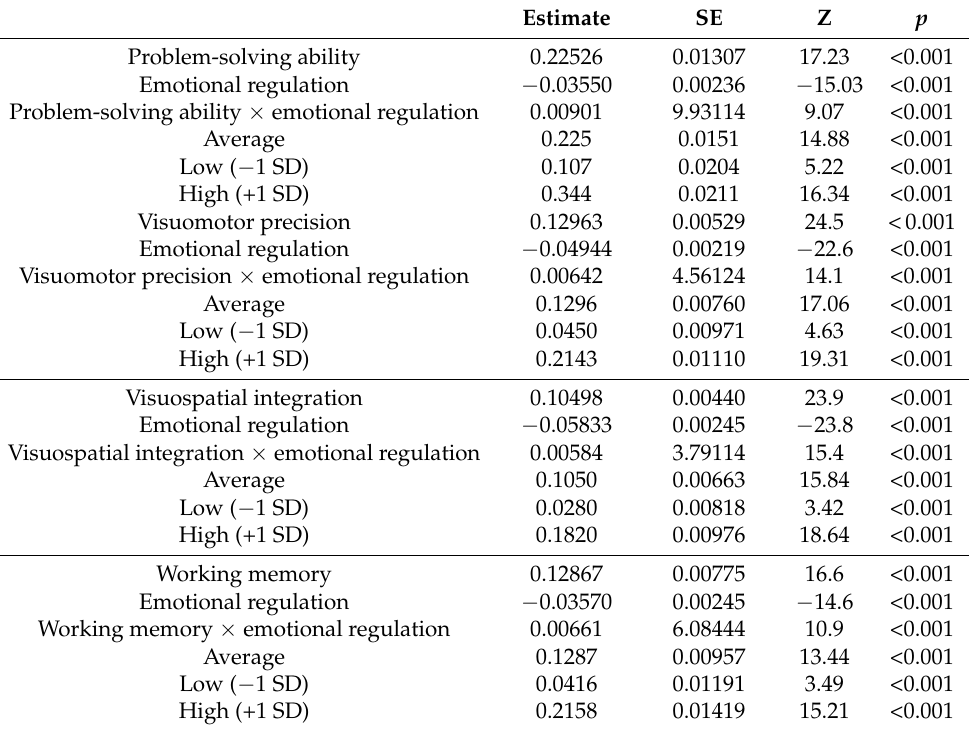
Table 3. The effect of the predictors (problem-solving ability, visuomotor precision, visuomotor integration, working memory) on the dependent variable (school results) at different levels of the moderator (emotional regulation) for the study group. Estimate SE Z p Problem-solving ability 0.22526 0.01307 17.23 <0.001 Emotional regulation − 0.03550 0.00236 − 15.03 <0.001 Problem-solving ability × emotional regulation 0.00901